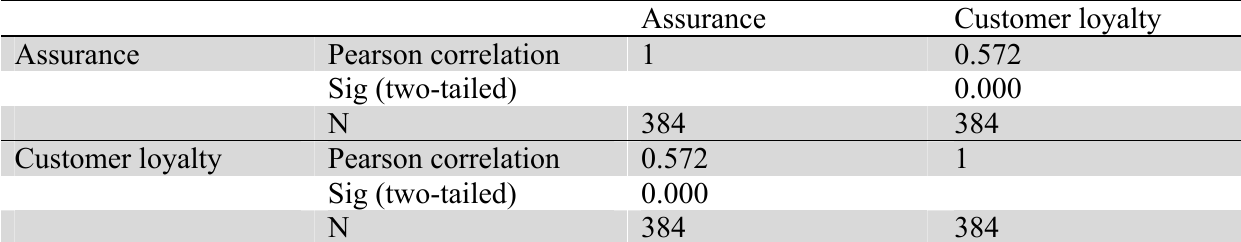
Assurance Customer loyalty